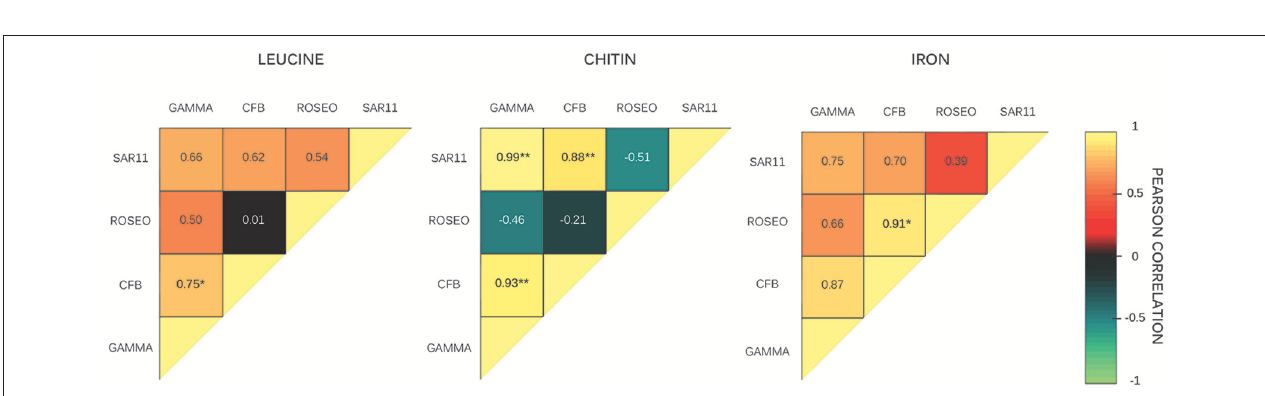
FIGURE 4 | Box plots displaying (A) the relative contribution of prokaryotic groups to the total leucine-, chitin-, and iron- active community (%) and (B) the proportion of leucine-, chitin-, and iron- active cells within each prokaryotic group (%)- note that scale is different for chitin and iron as compared to leucine). The black and the dashed lines across the box represent respectively the median and the mean (all stations included). The ends of the boxes define the 25th and 75th percentiles and error bars define the 10th and 90th percentiles. Outliers are plotted in black dots. ARCH, Archaea; CREN, Crenarchaeota; CFB, Cytophaga/Flexibacter/Bacteroides; ROSEO, Roseobacter clade; SAR11, SAR11 cluster; SAR86, SAR86 cluster; SAR92, SAR92 cluster.